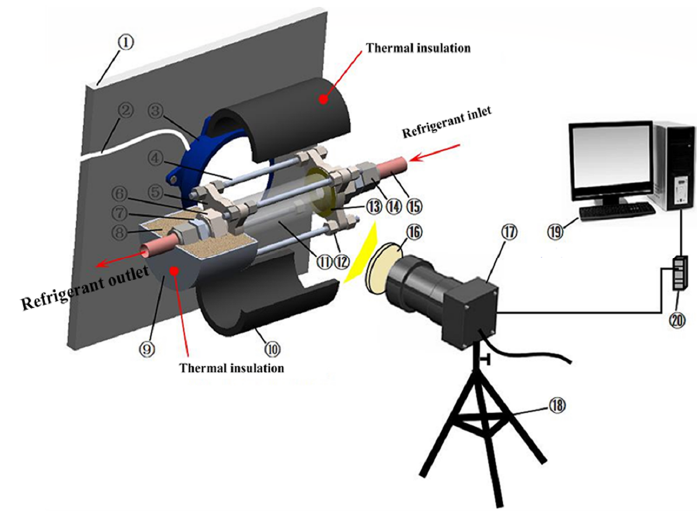
Figure 7. Acquisition equipment for flow patterns.